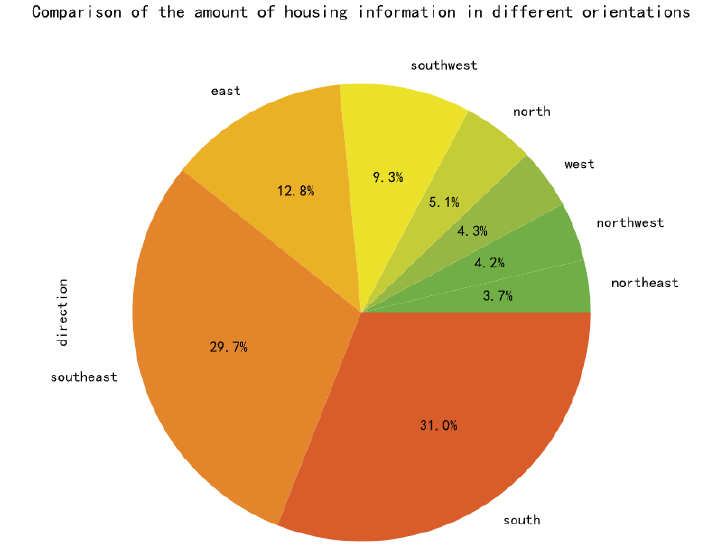
Fig. 6 Number of houses with various orientations